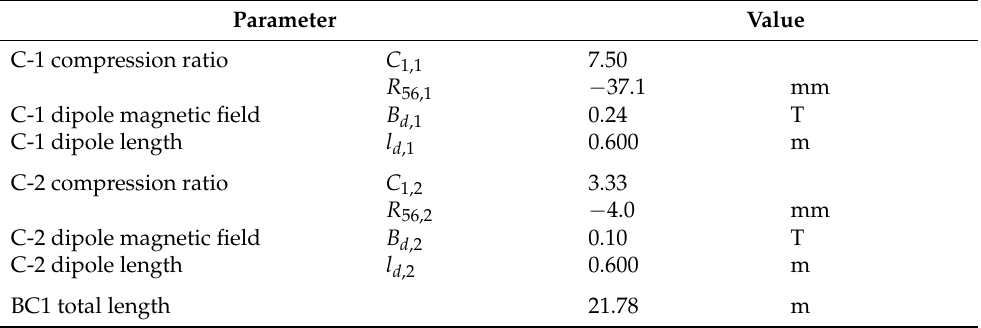
Figure 6. Contour plot of the value of σ , the current-weighted standard deviation of the slice- x (cid:48) slice average horizontal kick of all the beam slices, varying according to C-1 compression ratio and C-2 bending magnet length l d ,2 at B d ,2 = 0.10 T. The white marker is placed at the minimum of σ on x (cid:48) slice the contour plot. A 2D scan was performed for each B d ,2 value, constituting a 3D parameter scan. Table 4. BC1 double C-chicane design